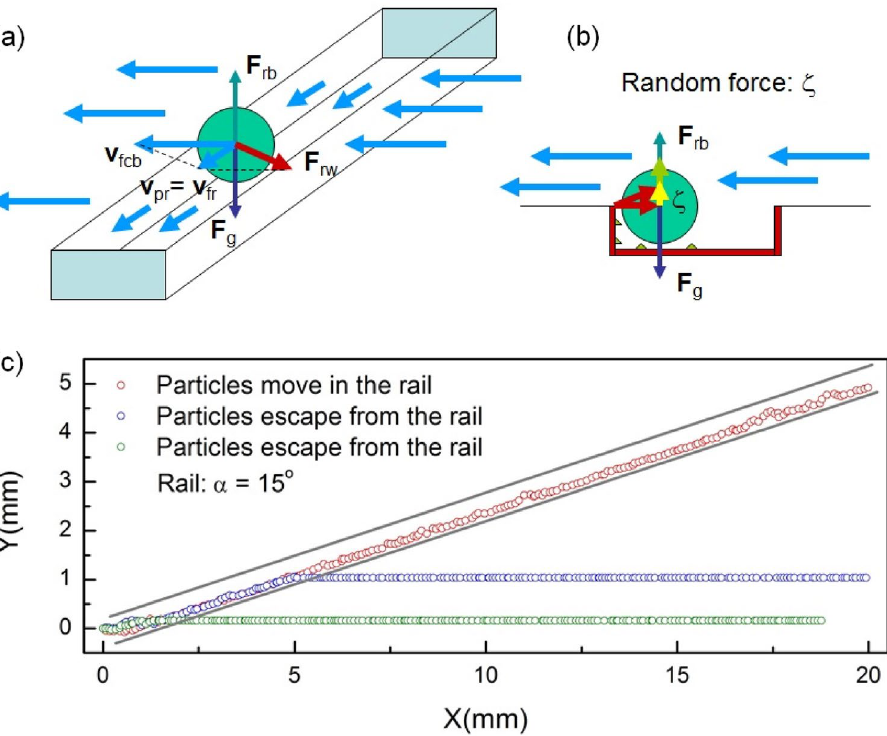
Figure 8. ( a ) The motion of a particle, driven by the fluid flow, in the rail. Long blue arrows show the fluid flow in the chip, and short blue arrows indicate the flow in the rail. Main forces and velocities (in the overdamped regime): the gravity force, F g , is compensated by the reaction force from the bottom of the rail F rb , the particle velocity in the rail, v pr , proportional to the fluid velocity in the rail resulting from the fluid velocity at the bottom of the chip, v fcb , and the wall reaction force F rw . ( b ) Imperfections at the bottom and lateral walls of the rail are modeled by a random force. ( c ) Examples of simulated particle trajectories: particles escape from the rail (blue and green circles) and following the rail (red